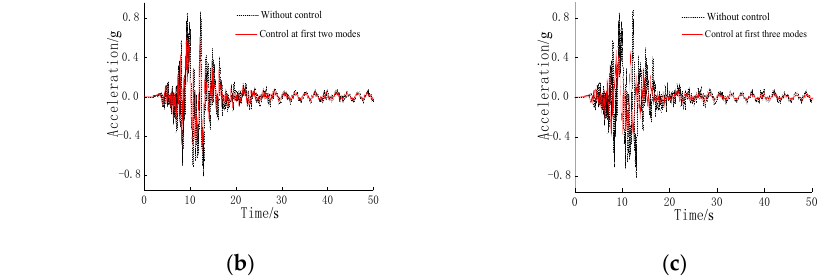
Figure 21. Time history of displacement by optimized control at different modes under the artificial wave. ( a ) First mode. ( b ) First two modes. ( c ) First three modes.